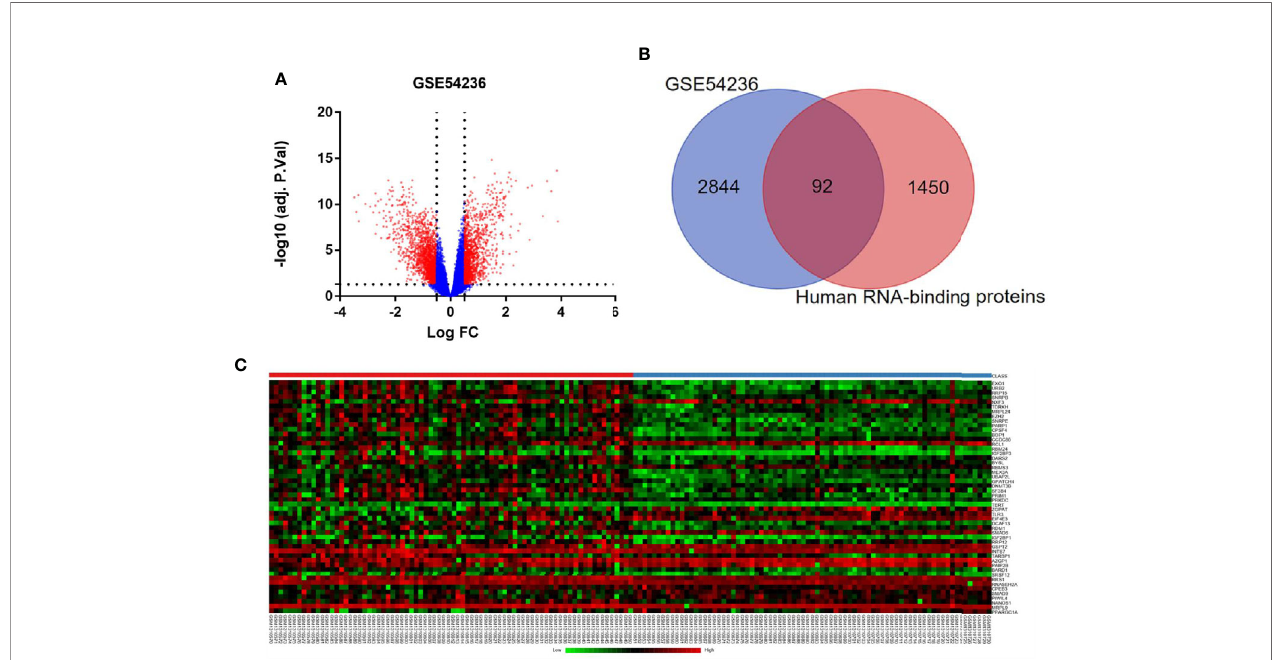
FIGURE 1 | Differently expressed RBPs in hepatocellular carcinoma. (A) Volcano plots of DEGs from GSE 54236. Red plots represent genes with log |FC| ≥ 0.5 and adjusted P-value ≤ 0.05. (B) Venn diagram of the overlap between the DEGs from GSE 54236 and candidate RBP genes catalog. (C) Heatmap of top 50 differently expressed RBP